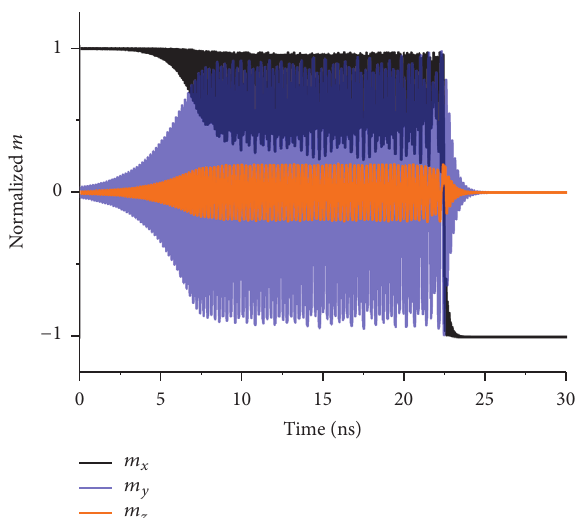
Figure 6: Free layer magnetization components during a switching process. The applied current density is 1.2 × 10 11 A/m. The magnetization oscillating time before switching is 22ns.